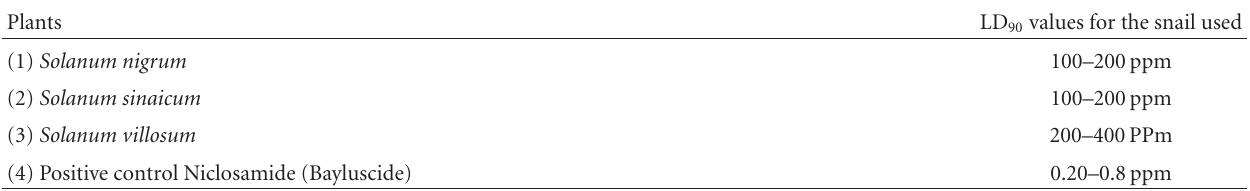
Table 1: The results of molluscicidal evaluation of the 3 plants examined. Plants LD 90 values for the snail used